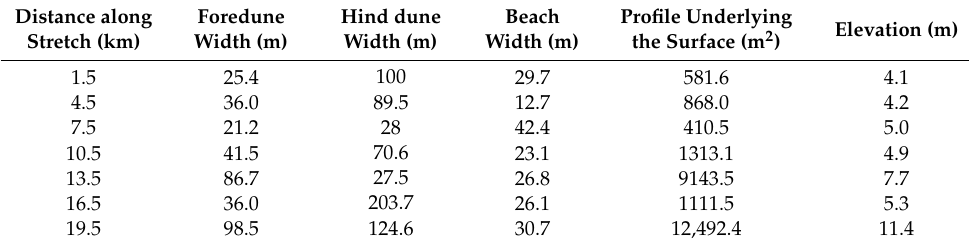
Table 5. Beach–dune system